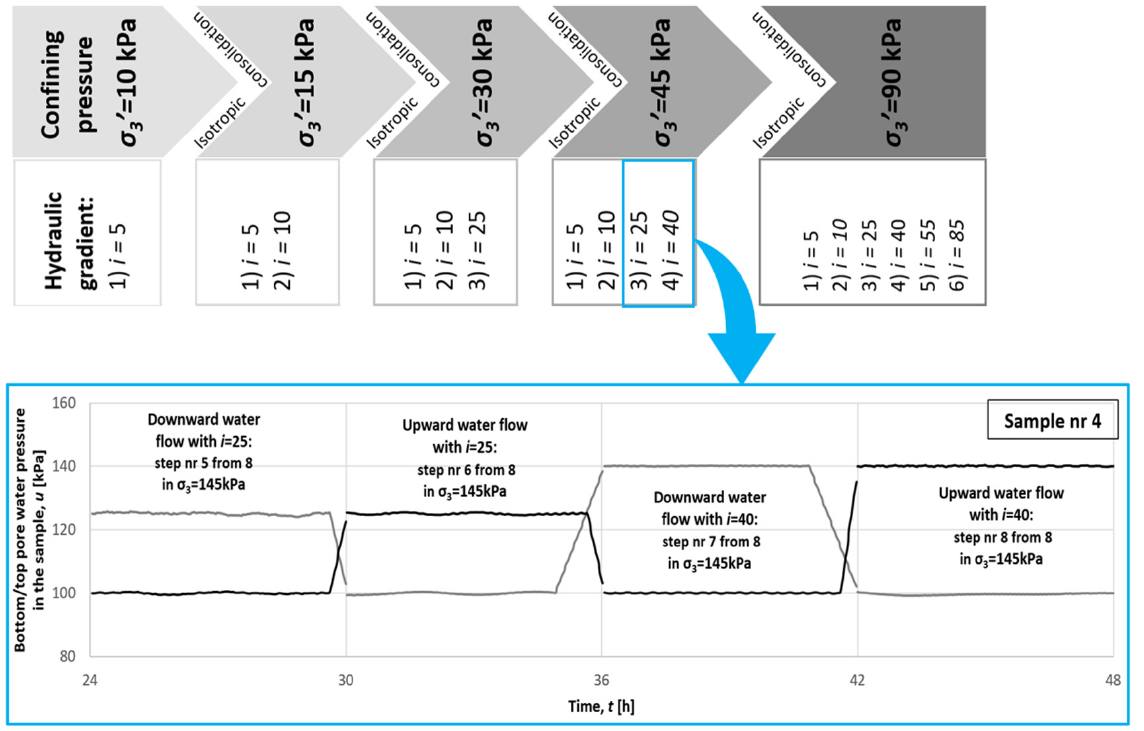
Figure 4. The applied triaxial tests scheme for determining the hydraulic conductivity values.